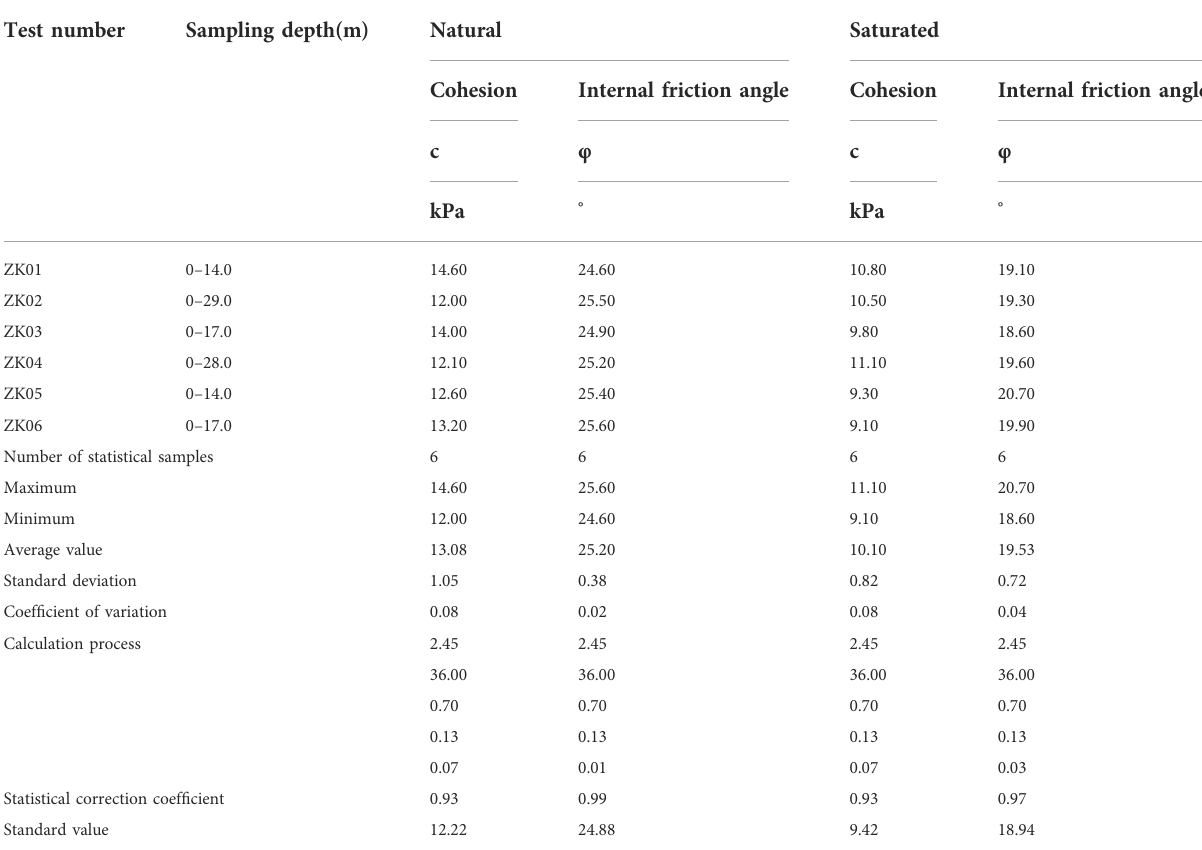
TABLE 1 Statistical table of soil mechanical parameters in landslide area. Statistical table of mechanical performance parameters test results in landslide area (undisturbed